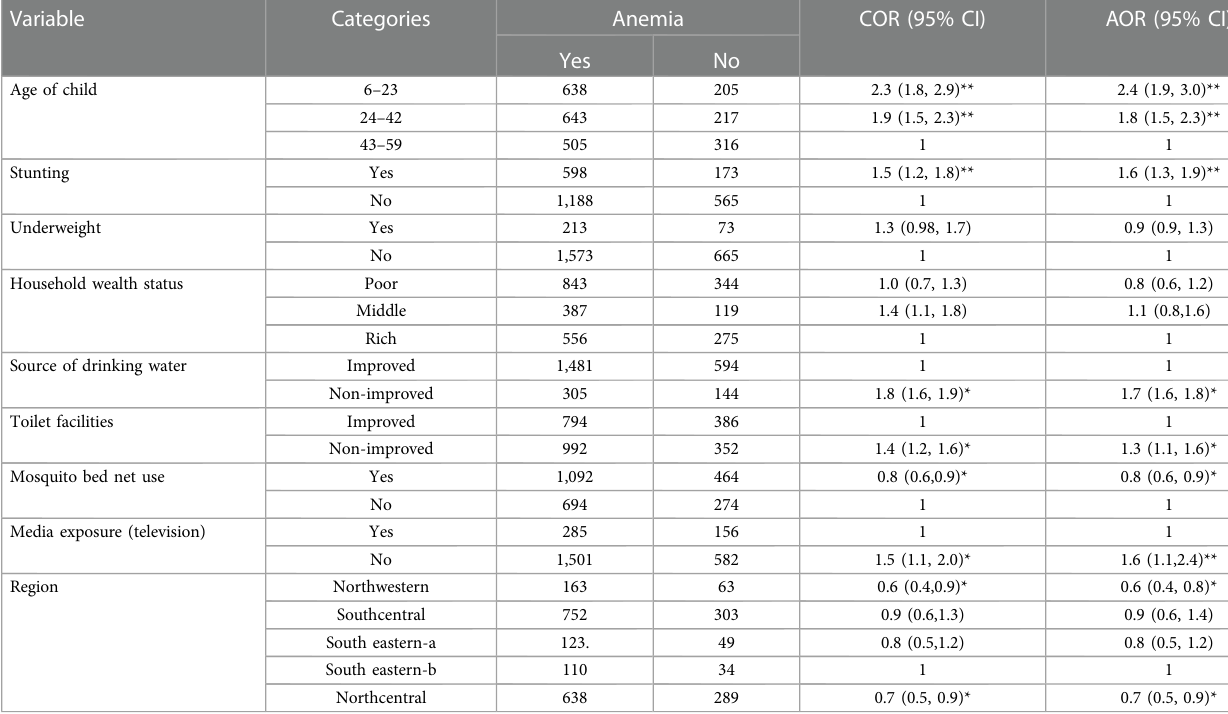
TABLE 4 Individual and community-level factors associated with anemia among children aged 6 – 59 months in Liberia, 2019/20 ( N =2,524).